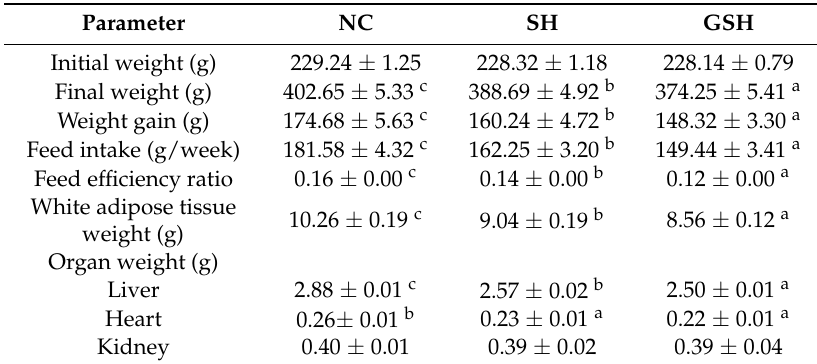
Table 3. Body weight gain and weights of organs and adipose tissue in ovariectomized rats fed with germinated Superhongmi rice powder.